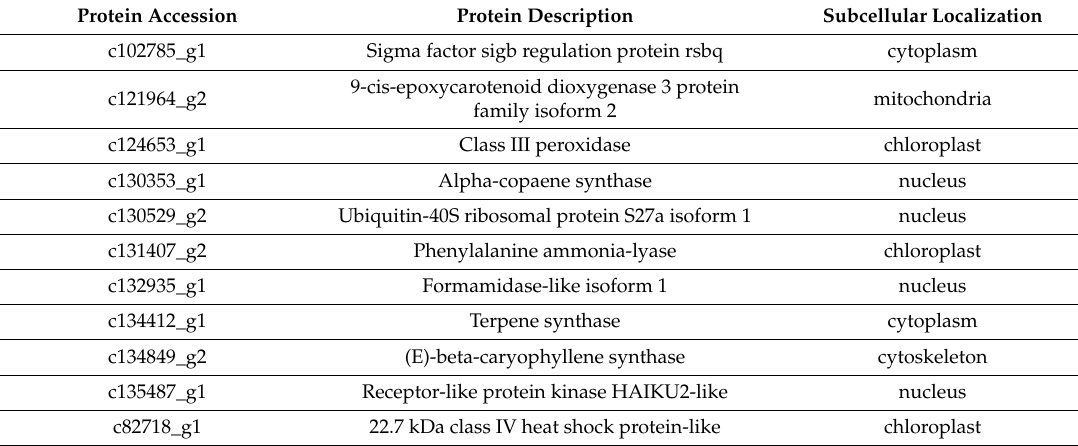
Table 3. Proteins participated in pollen tube growth in C.